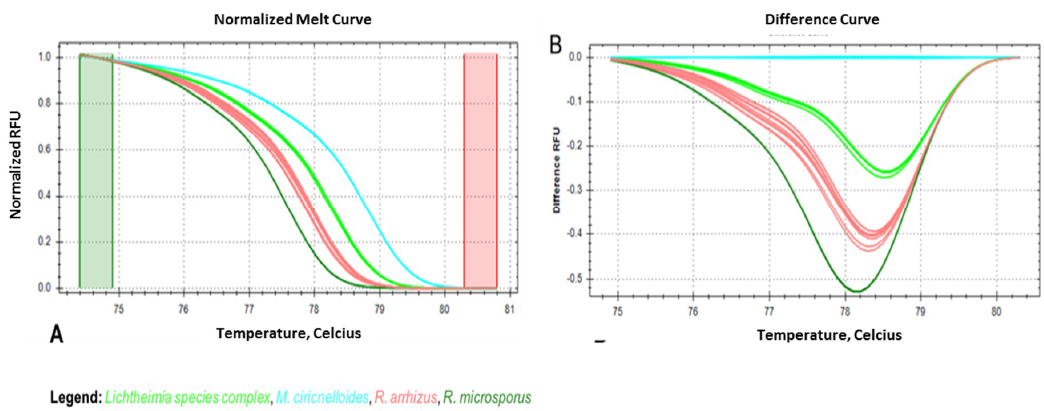
Figure 5. Sensitivity of the rnl real-time PCR-HRM assay for human EDTA-whole blood samples spiked with R. arrhizus conidia in serial dilutions. ( A ) Normalized melt curve and ( B ) difference curves for individual species.